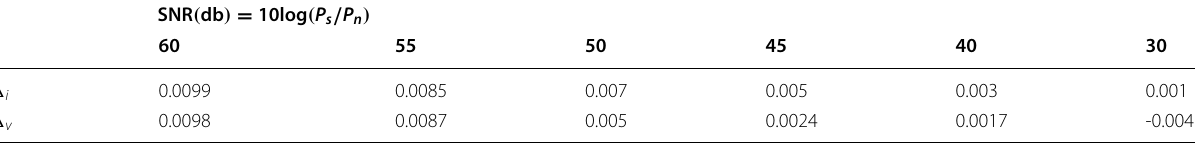
Table 6 White noise effect on proposed criteria